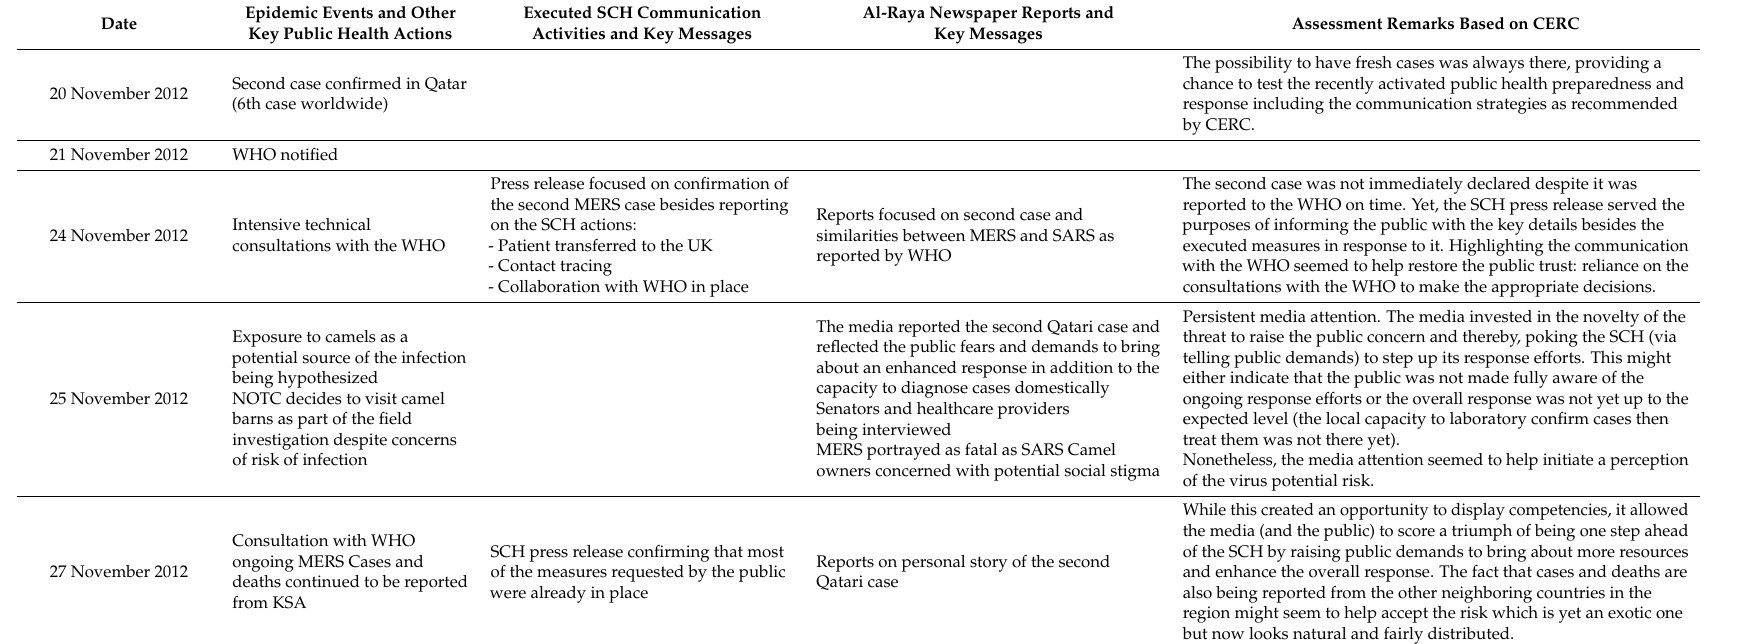
Table 2. Second phase of the epidemic (20 November 2012–August